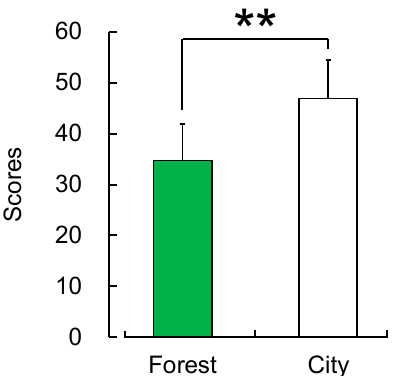
Figure 7. The participants’ levels of state anxiety after viewing forest and city areas, as measured by the state anxiety score of the State–Trait Anxiety Inventory questionnaire. Data are expressed as means ± standard deviation ( n = 65). ** p < 0.01, Wilcoxon signed-rank test (one-sided).